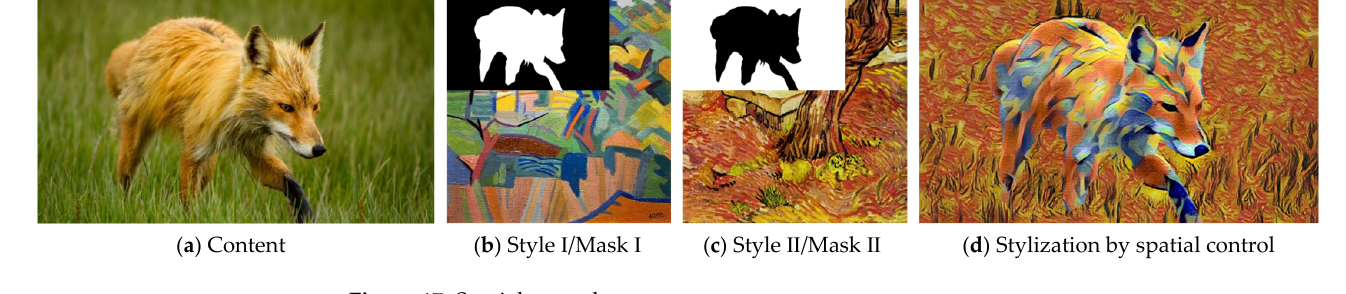
Figure 17. Spatial control.